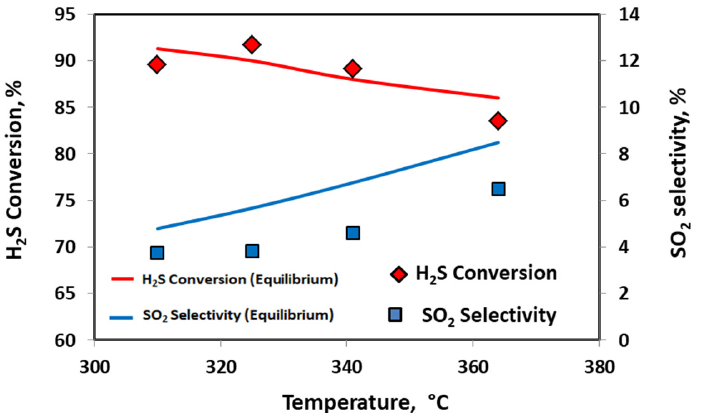
Figure 3. Temperature effect over 20 V-CeO 2 catalyst on the H 2 S conversion and SO 2 selectivity (H 2 S = 10 vol%, contact time = 0.6